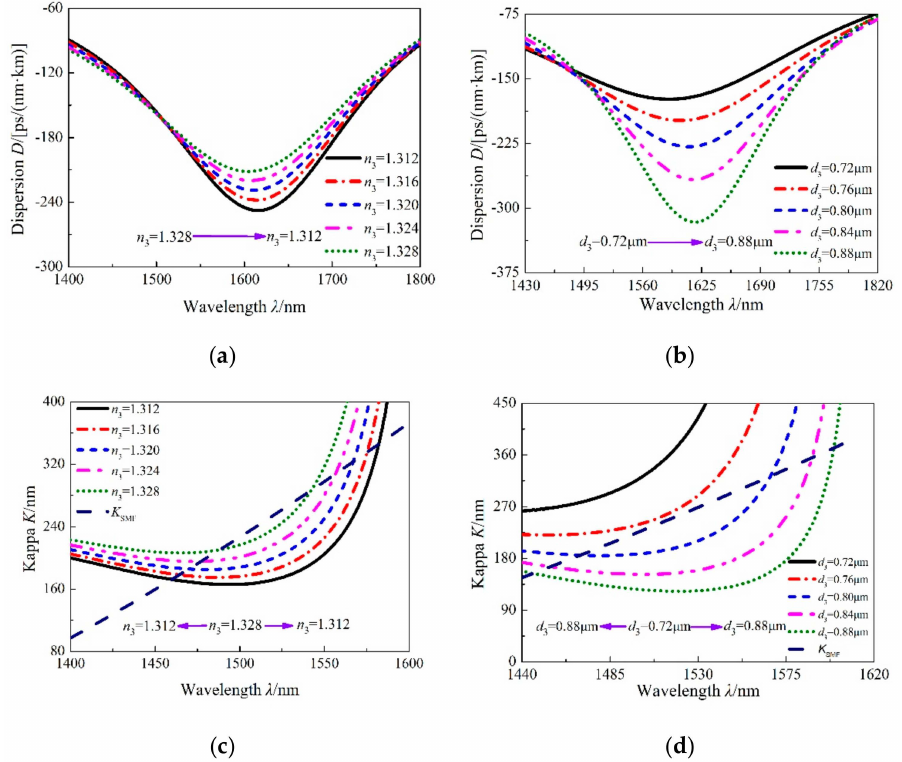
Figure 6. Variation of dispersion ( a ), ( b ) and K value ( c ), ( d ) with n 3 and d 3 ,